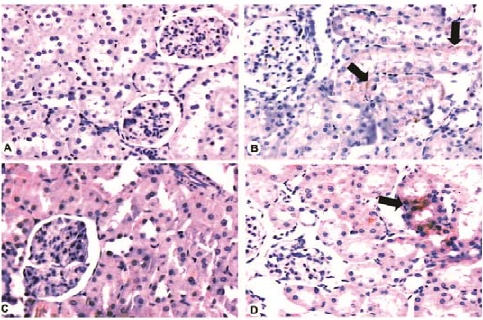
Figure 1. Immunohistochemistry for myoglobin and hemoglo- bin in the renal tissue of control and venom-injected rats. A. Negative staining for myoglobin (200 X). B. Positive tubular cytoplasm staining for myoglobin (black arrows). Note tubular necrosis in the same area (200 X). C. Negative staining for hemoglobin (200 X). D. Positive tubular cytoplasm staining (black arrows) for hemoglobin (200